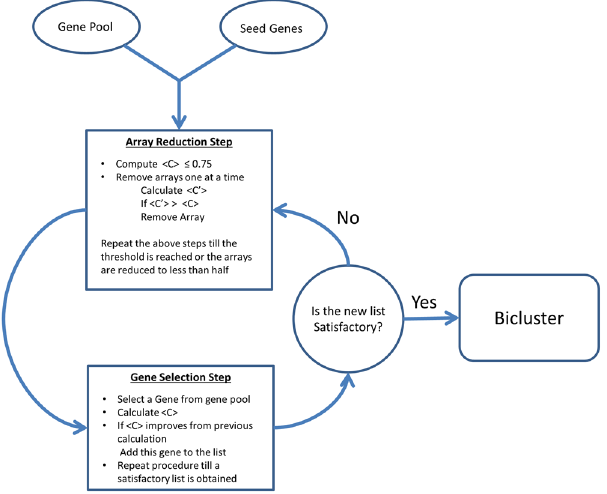
Figure 4. Flow diagram describing Biclustering algorithm. Seed genes are a predefined group of genes. The gene pool is the set of genes to be tested for inclusion in the bicluster. < C > indicates mean pairwise correlation, < C ′> indicates new mean pairwise